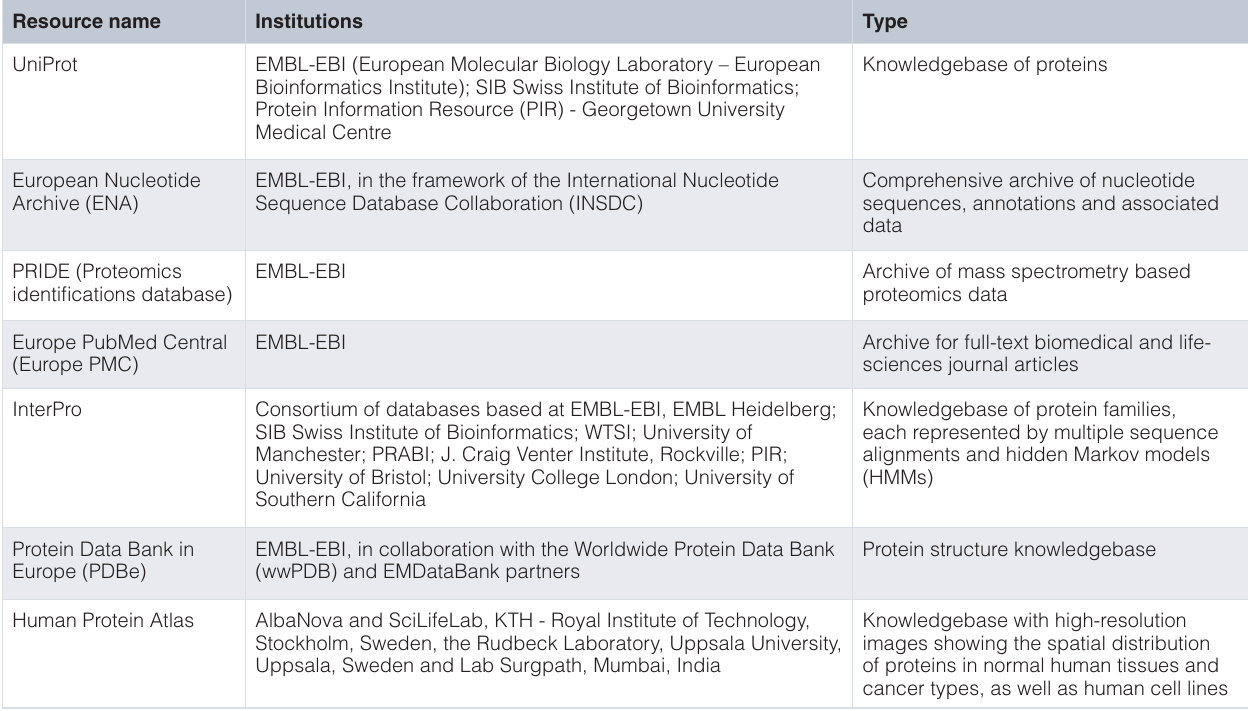
Table 2. Examples of European data resources that are considered as core for the life-science